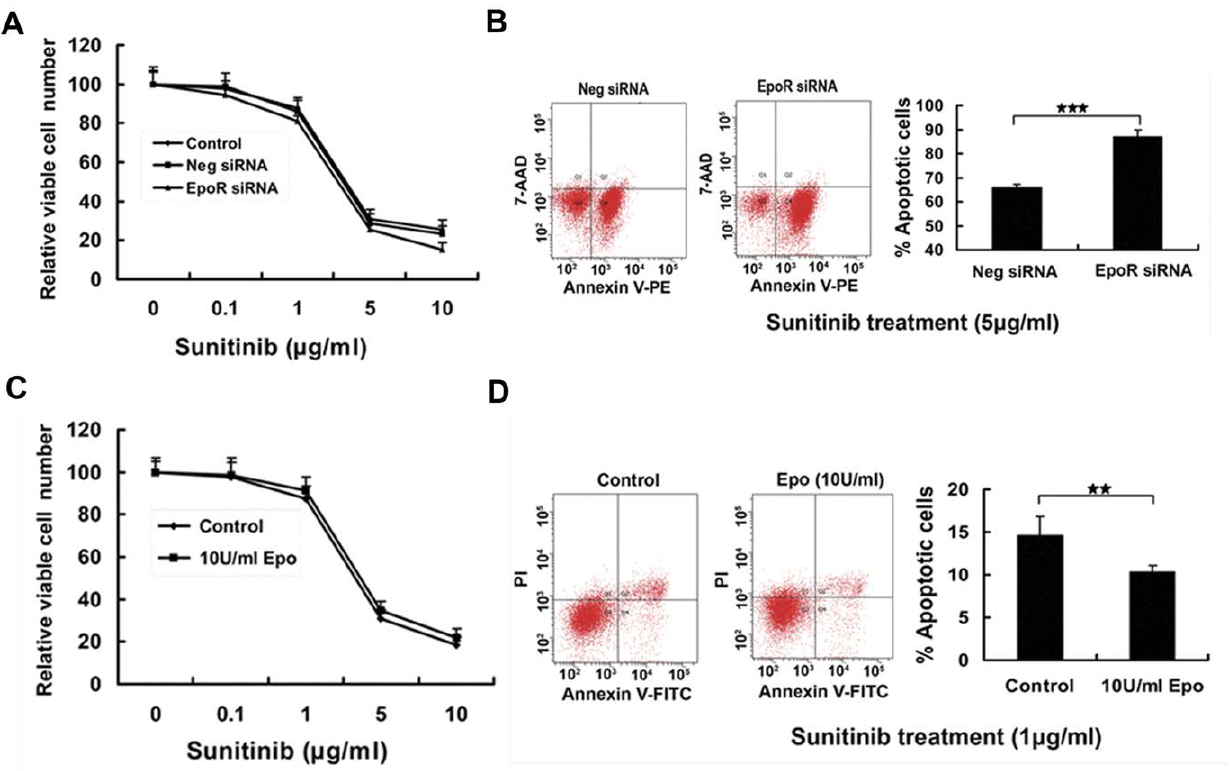
Figure 4. The effect of Epo/EpoR pathway on Sunitinib in 786-0 cells. (A) 786-0 cells stably expressing EpoR siRNA, 786-0 cells stably expressing negative siRNA, and parental 786-0 cells were incubated in the medium containing various concentrations of Sunitinib for 24 hours, and the viable cells were measured by modified MTT method. Error bar represents mean 6 SD from 6 wells for each time point and triplicate experiments for each sample. 786-0 cells stably expressing EpoR siRNA were slightly more sensitive to Sunitinib than the two controls. (B) 786-0 cells stably expressing EpoR siRNA were cultured in medium containing 5 m g/ml Sunitinib for 24 hours, then subjected to assess cell apoptosis by flow cytometry. Suntinib treatment caused more apoptotic cells(Annexin V-PE + /7-AAD + / 2 )in 786-0 cells stably expressing EpoR siRNA than in 786-0 cells stably expressing negative siRNA ( www : P , 0.001). (C) 786-0 cells were exposed to various concentrations of Sunitinib with or without 10 U/ml Epo for 24 hours and assessed relative viable cell number by modified MTT assay. Error bar represents mean 6 SD from 6 wells for each time point and triplicate experiments for each sample. Epo slightly antagonized the effect of Sunitinib. (D) 786-0 cells were cultured in medium containing 1 m g/ml Sunitinib with or without 10 U/ml Epo for 24 hours, and apoptotic cells (Annexin V-FITC + /7-AAD + / 2 )were measured by flow cytometry. Epo attenuated the effect of Sunitinib ( P , 0.01, from 4 repeated experiments).